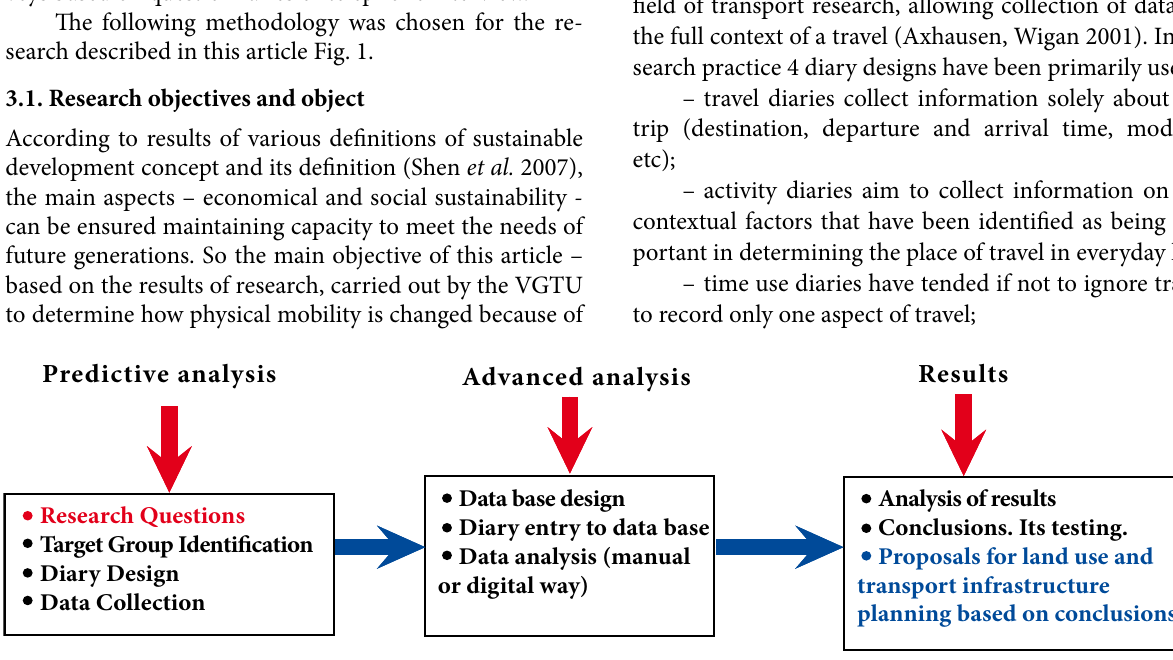
Fig. 1. Sequence of research